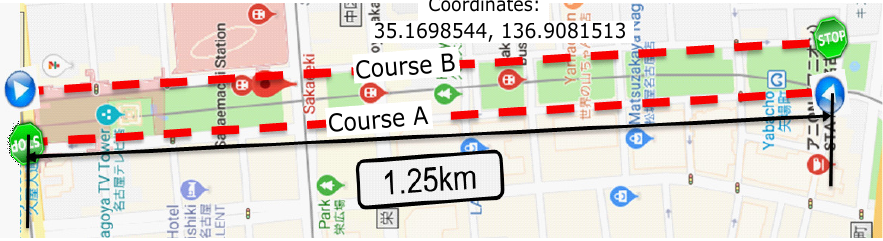
Figure 3. Route of the driving experiment (Sakae) showing the two courses (Course A and Course B), with the relative GPS coordinates of the area.